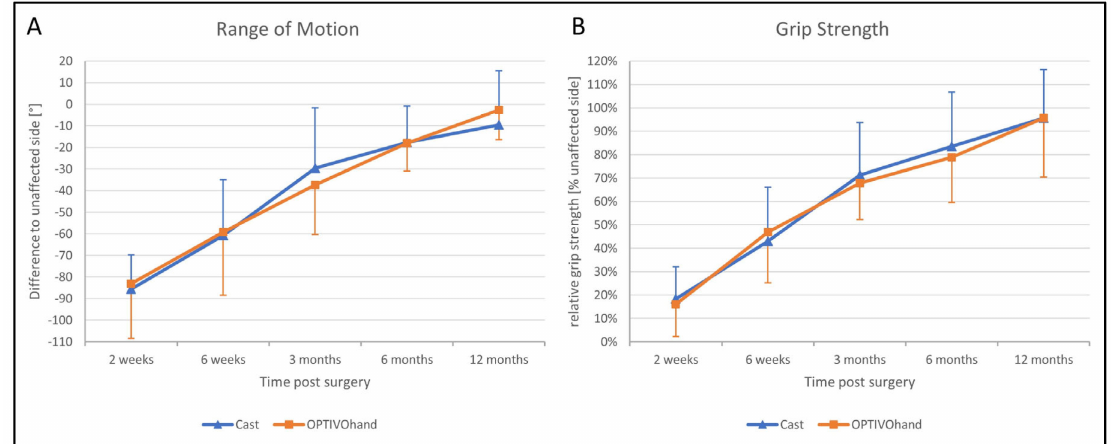
Figure 5. Functional outcome (( A ) range of motion; ( B ) grip strength) after 2 weeks to 12 months